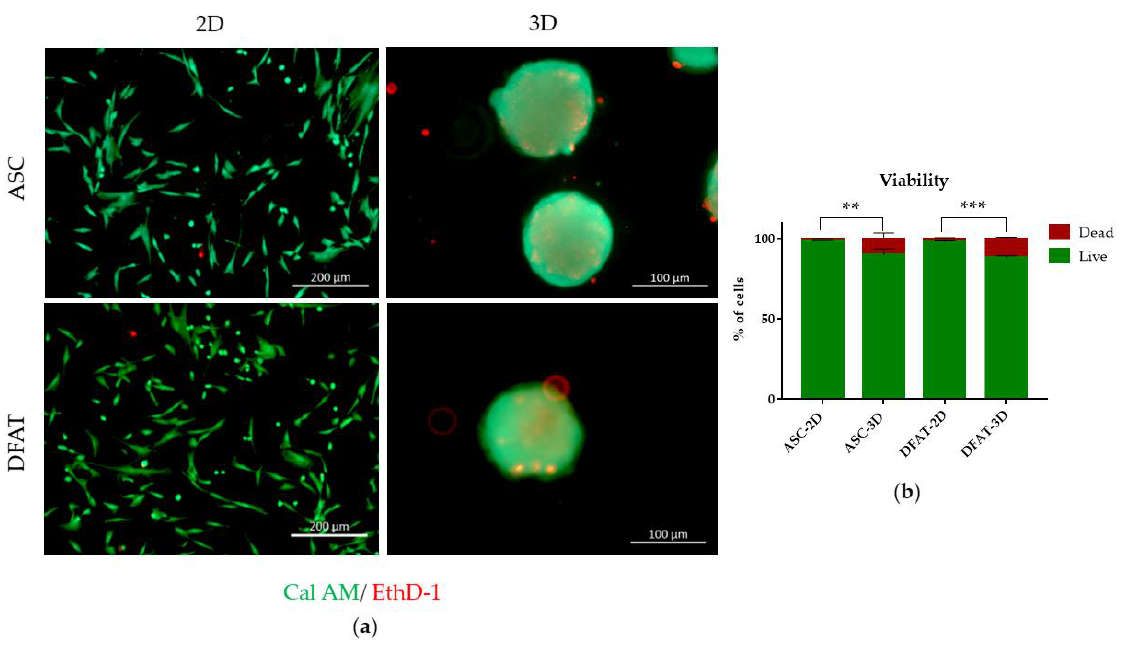
Figure 4. The viability of ASCs and DFATs cultured as a monolayer and as a spheroid. ( a ) Fluorescent microscope images of ASCs and DFATs population, living cells stained by green CalceinAM (CalAM), dead cells stained by red Ethidium homodimer-1 (EthD-1). Scale bar= 200 µ m (2D) and 100 µ m (3D); ( b ) The average percentage of dead and live cells in populations of ASCs and DFATs cultured in 2D and 3D conditions. The results are presented as mean values of 3 experiments ± SD, for ** p < 0.01, *** p < 0.0001.